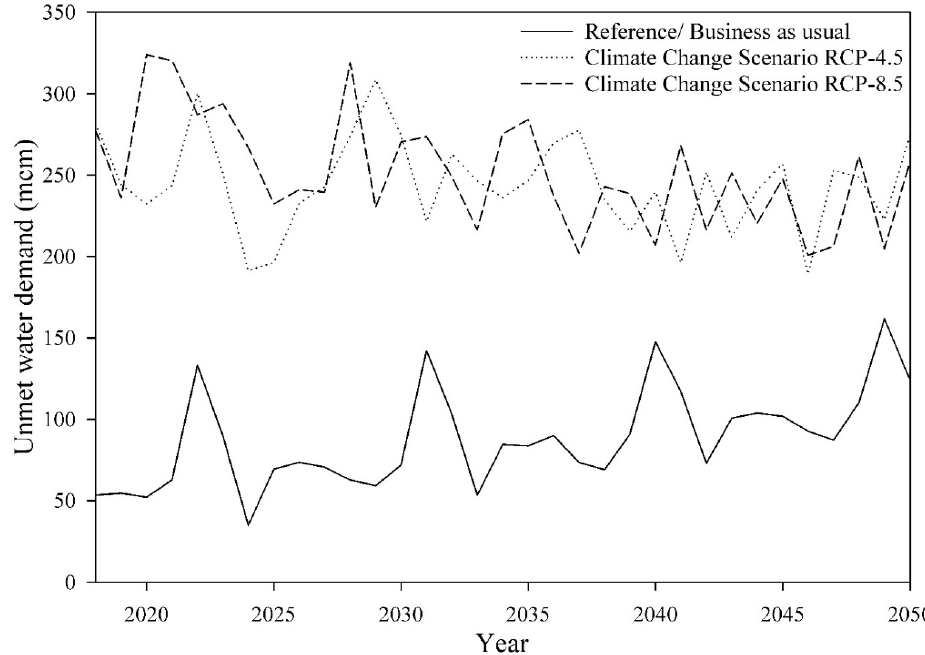
Figure 14. The unmet water demands in the Upper Indus Basin (UIB) under the reference scenario and in the RCP-4.5 and RCP-8.5 scenarios for the period 2014–2050.